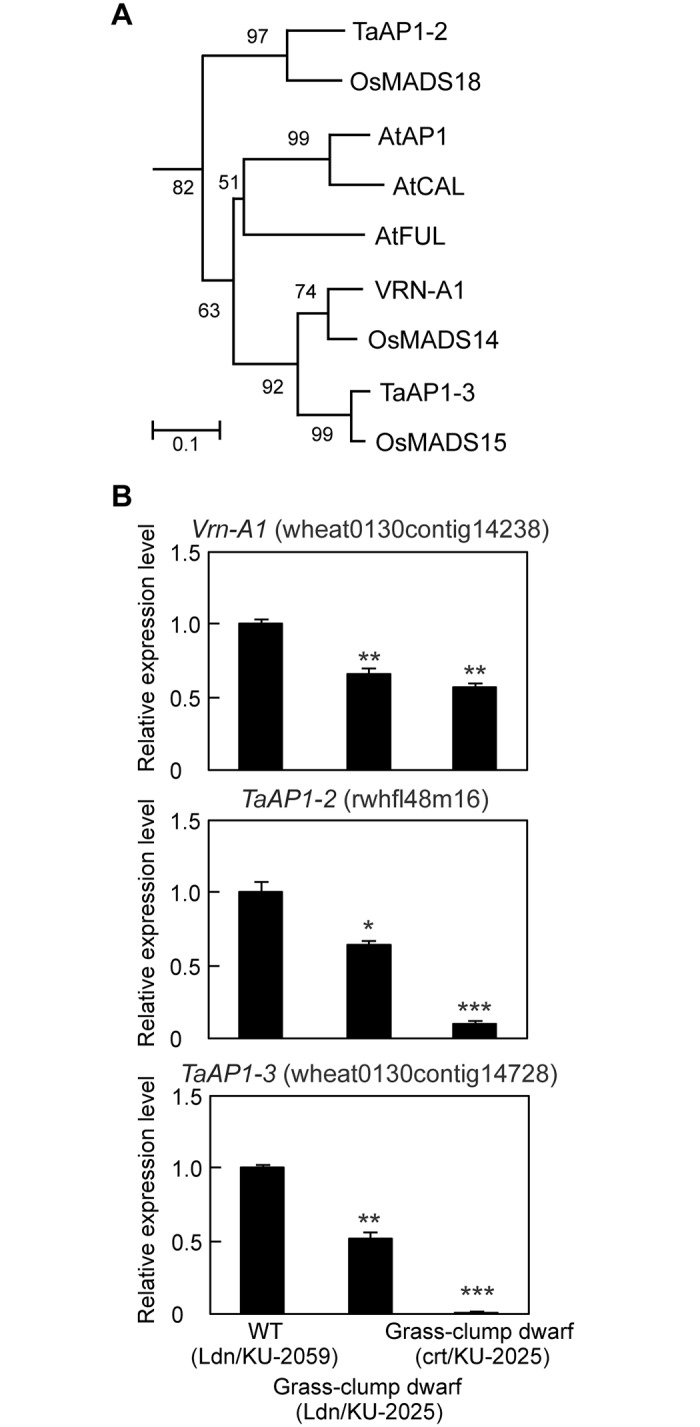
Comparison of transcript accumulation of the three MADS-box genes in crown tissues of the WT and type II necrosis/grass-clump dwarf lines.(A) Phylogenetic tree of the deduced MADS-domain amino acid sequences in the AP1/FUL-type MADS-box genes from Arabidopsis, rice and wheat. Bootstrap values after 1,000 replicates are shown at nodes. (B) Transcript accumulation levels of the three MADS-box gene transcripts from qRT-PCR. The transcript levels are shown as values relative to those in crown tissues of Ldn/KU-2059 under normal temperature. Means ± SD were calculated from data obtained in three experiments. The Actin gene was used as an internal control. Student’s t-test was used to test for statistical significance (***P<0.001) between WT and grass-clump dwarf synthetic plants.